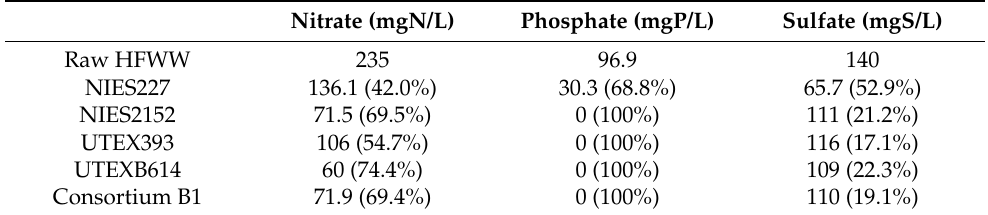
Table 3. Concentrations in nitrate (mgN/L), phosphate (mgP/L), sulfate (mgS/L), and their re- spective removal efficiency after 5 days of culture in pure HWW in flasks for four strains (NIES227, NIES2152, UTEX393, and UTEXB614) and one consortium